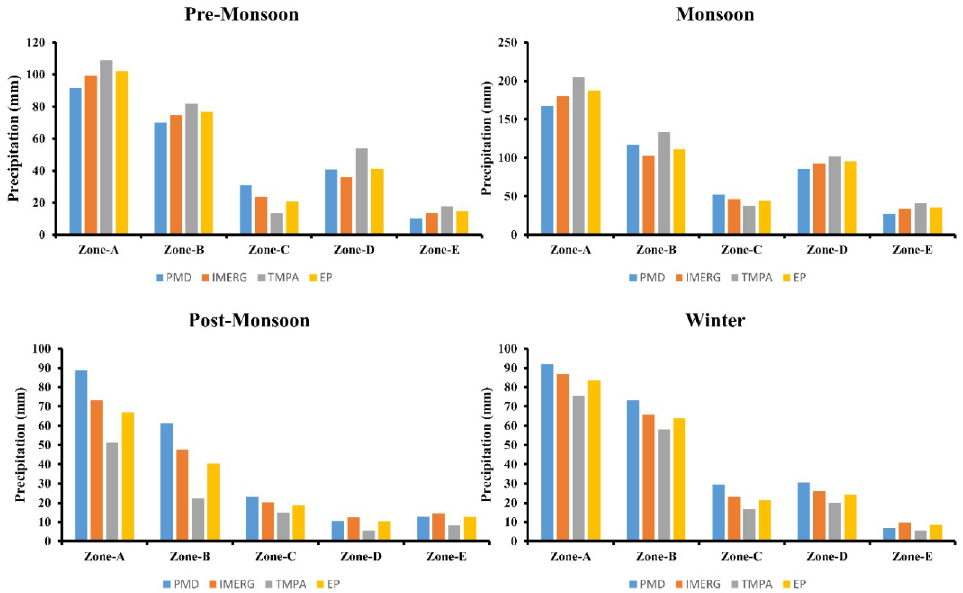
Figure 4. Comparison of mean seasonal (daily accumulated) precipitation over the five climate zones. The mean error (ME) and root mean square error (RMSE) over the five zones compared to the